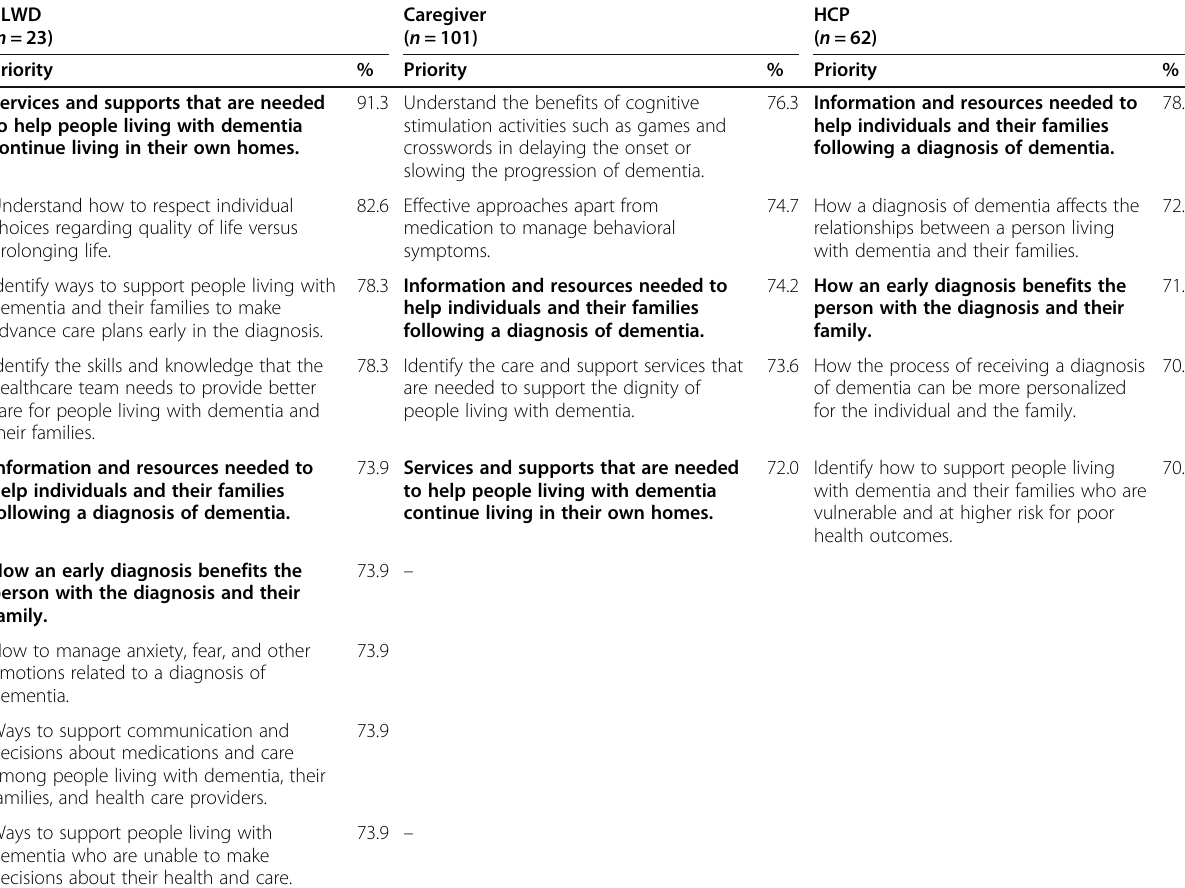
Table 2 Top 5 “ Very Important ” Priorities by Stakeholder